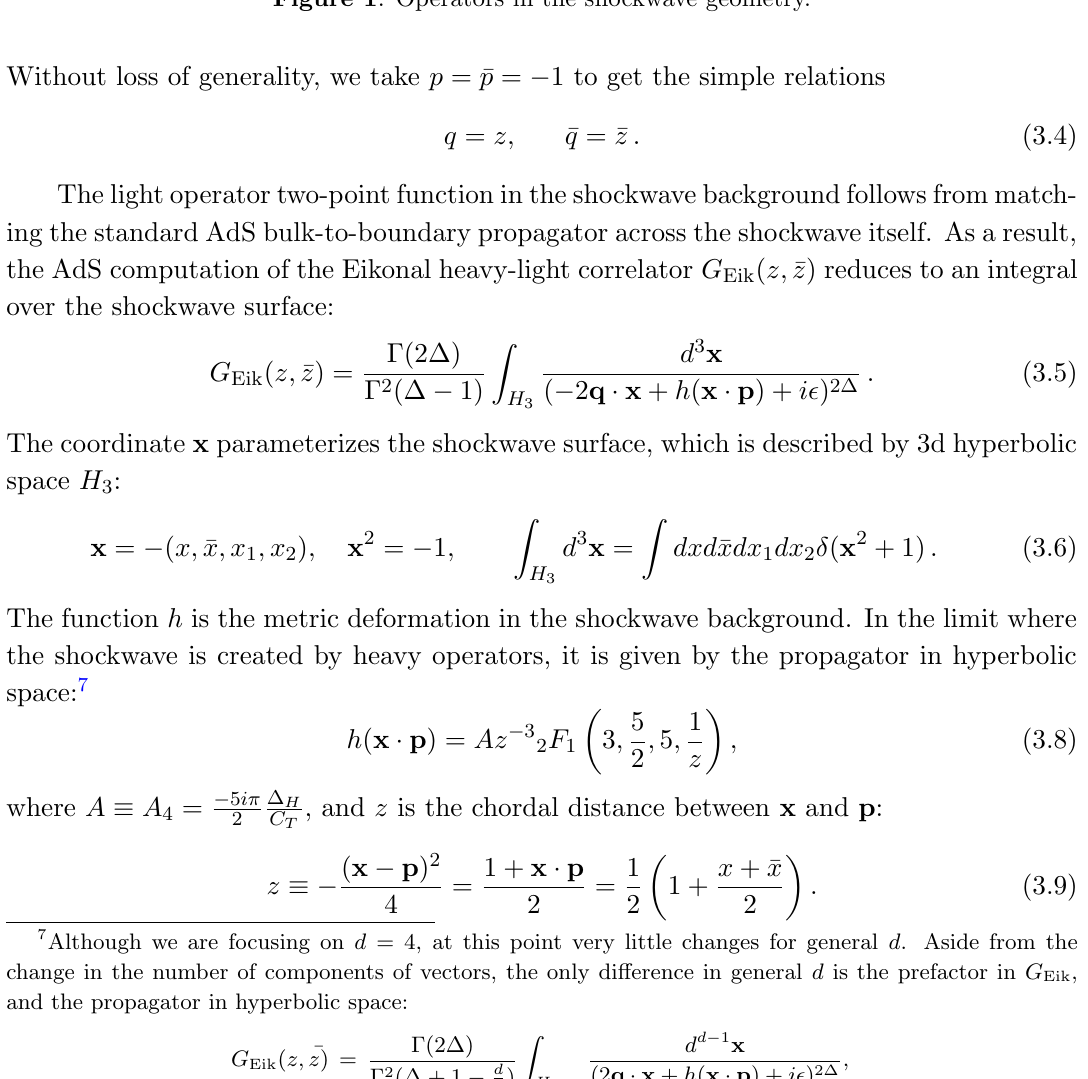
Figure 1 . Operators in the shockwave